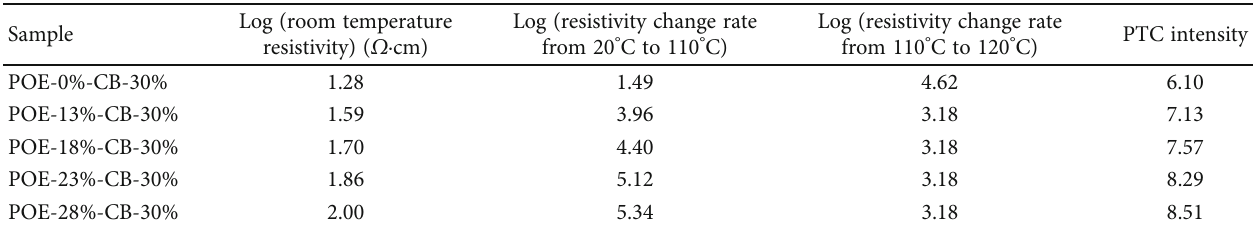
Table 3: The room temperature resistivity and resistivity change rate in di ff erent temperature ranges.